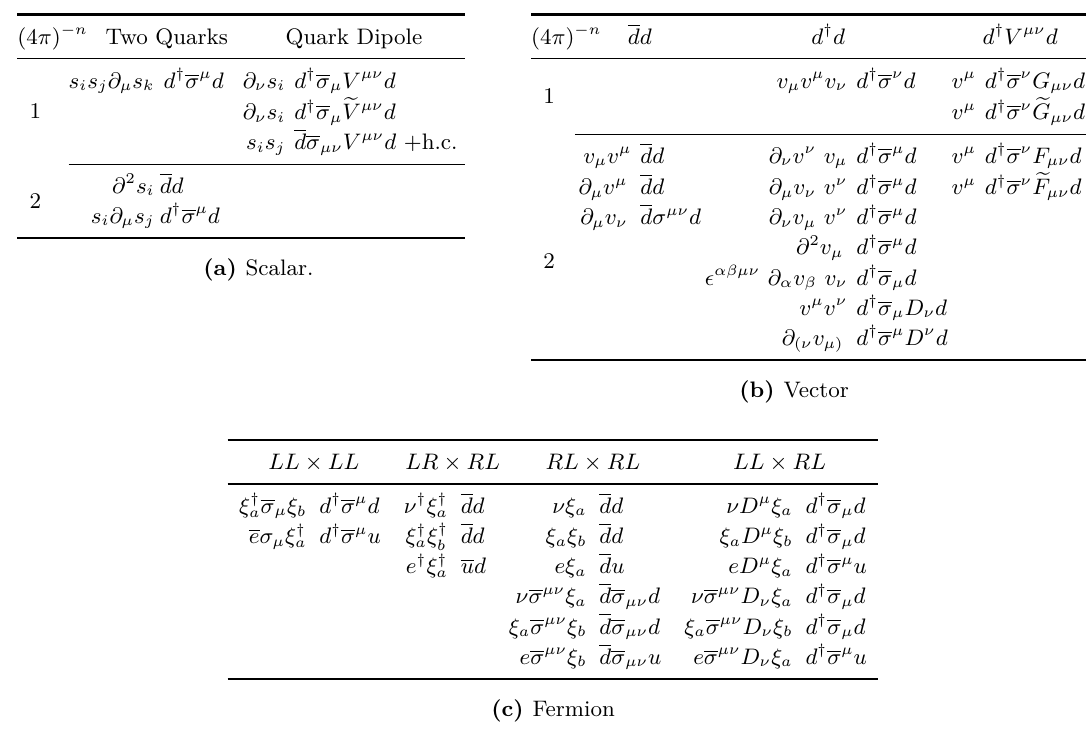
, or 1. Panel a shows the operators for 2 messengers, and panel b shows those for 2